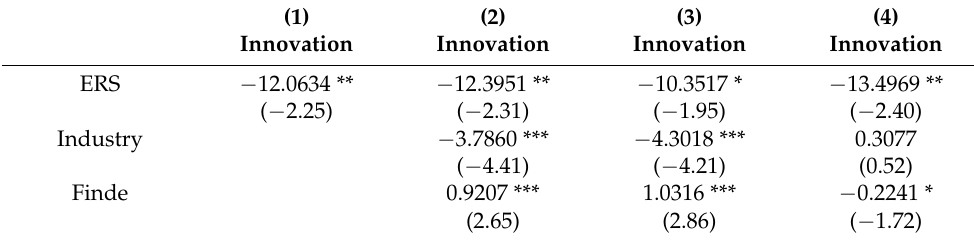
Table 5. Robustness test results excluding provincial capitals and